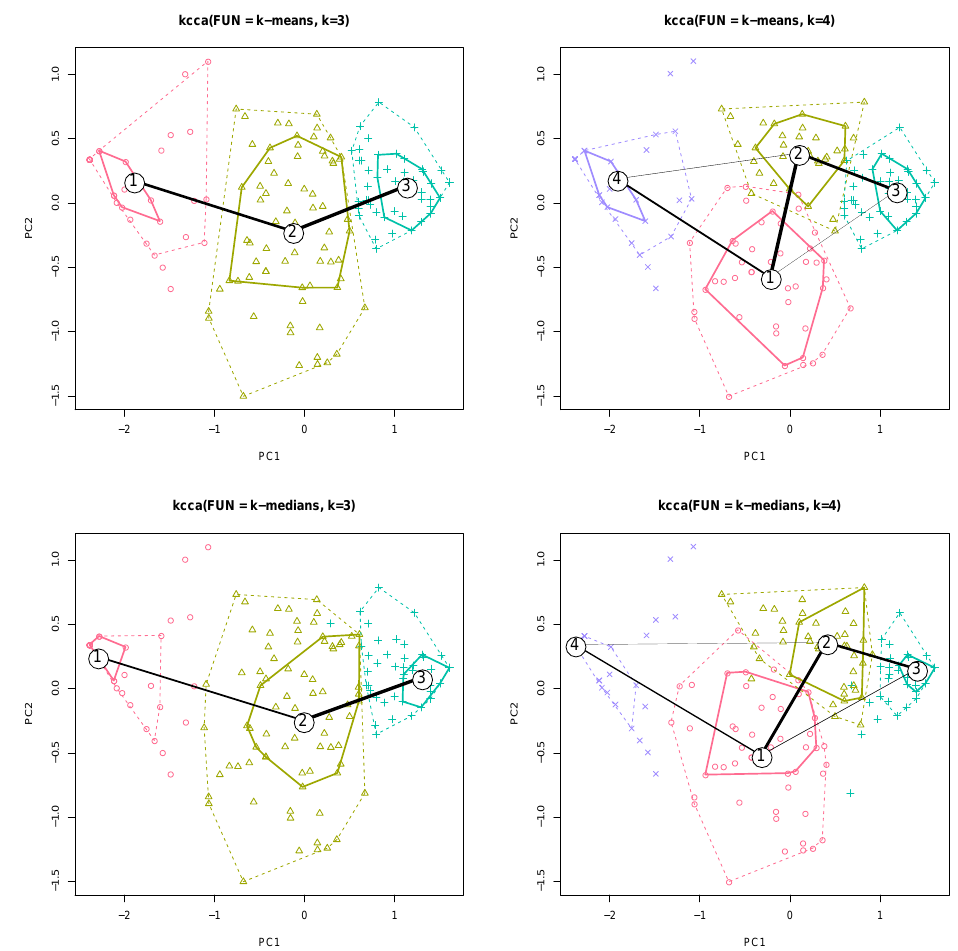
Figure 5. PCA plot for k—means and k—medians; k = 3 and k = 4 (solid line encloses 50% and dotted line encloses 95% of respondents in